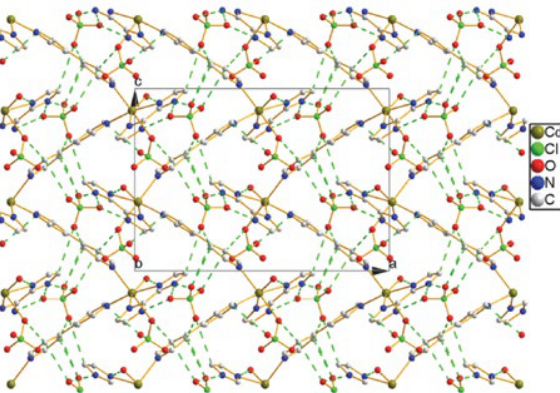
Figure 3. Packing diagram of complex 1 with the dashed lines rep- resenting the hydrogen bonding